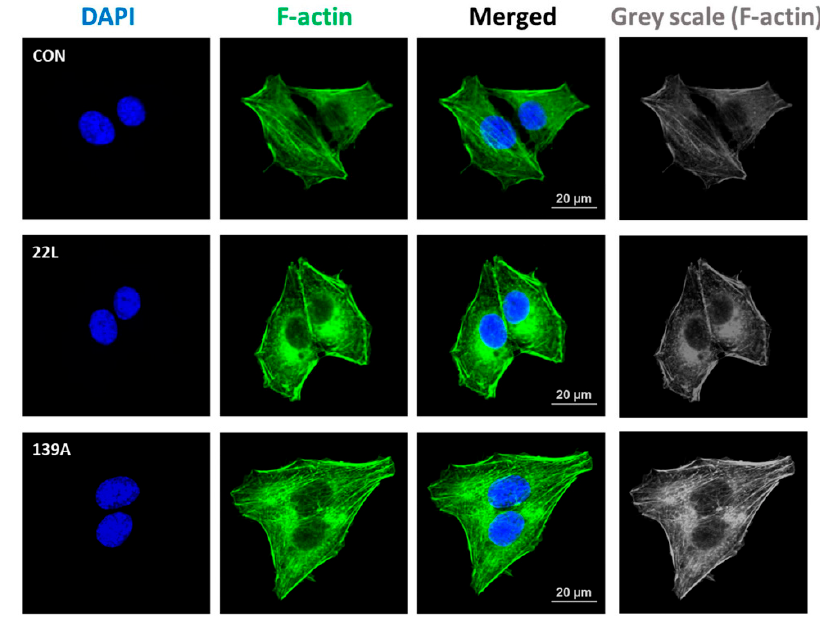
Figure 3. Scrapie infection increased F-actin formation. Immunocytochemical staining for F-actin in ZW13-2 cells with or without 22L or 139A scrapie infection. Cells were fixed with 4% paraformaldehyde (PFA) and permeabilized with 0.2% Triton X-100 in PBS. F-actin was stained with Alexa Fluor 488-phalloidin, and 4 ′ ,6-diamidino-2-phenylindole ( DAPI) was used to counterstain the nuclei. All pictures are representative of multiple images from three independent experiments (scale bars, 20 μ m).